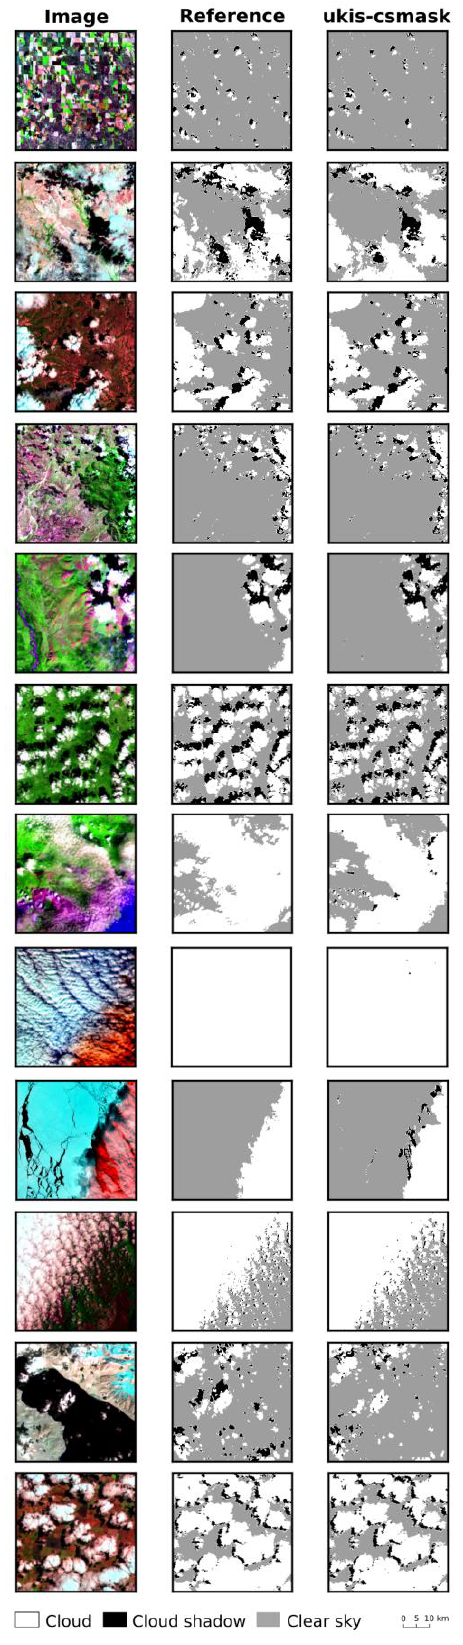
Figure 4. Selected ukis-csmask predictions on the Sentinel-2 cloud mask catalogue